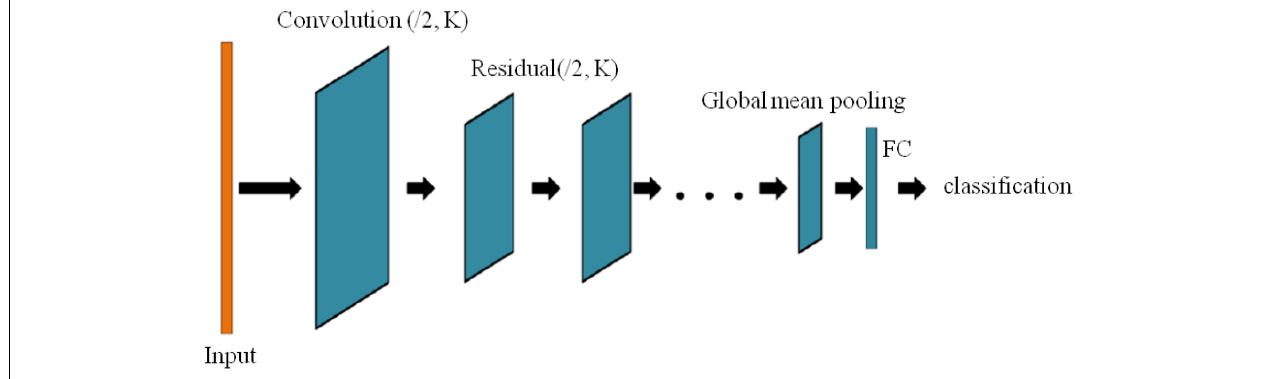
FIGURE 5 | Multi-Head Attention Residual Network Model.